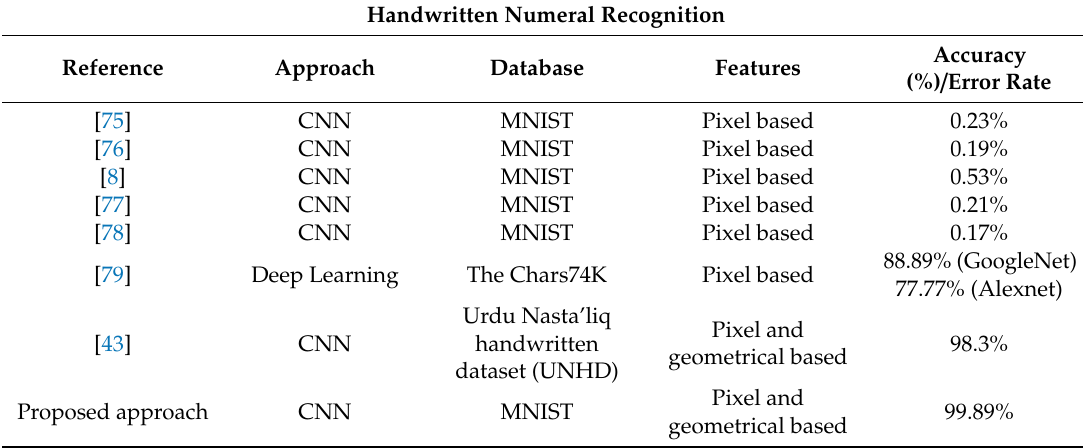
Table 5. Comparison of proposed CNN architecture for numeral recognition with other techniques. Handwritten Numeral